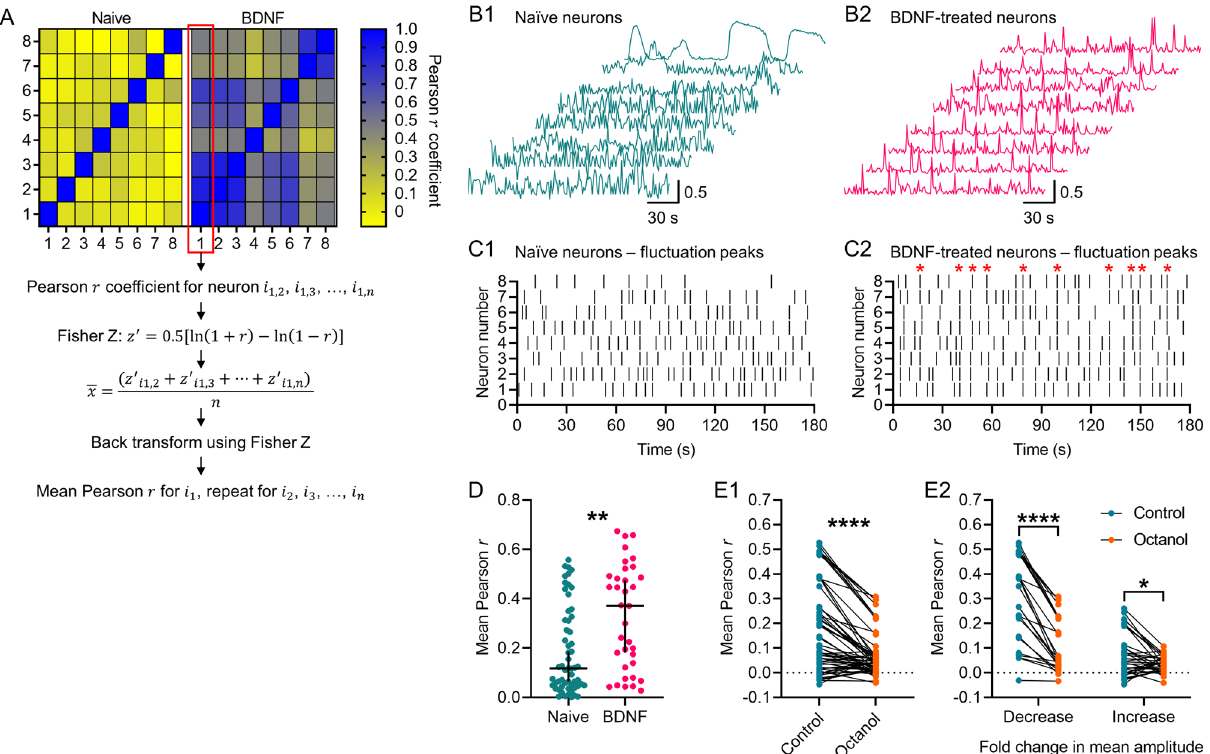
Figure 3. Synchrony of [Ca2 +] i fluctuations in BDNF-treated cultures and the effect of octanol. ( A ) Example adjacency matrix constructed from Pearson r coefficients corresponding to the correlation in activity between neurons in a naïve or BDNF-treated culture, each with 8 sampled neurons. Steps to calculate the mean Pearson r for each neuron within a culture using the Fisher Z transformation are also depicted. ( B1 , B2 ) Example recordings of asynchronous [Ca 2+ ] i fluctuations in naïve neurons and synchronous [Ca 2+ ] i fluctuations in BDNF- treated neurons. Recordings shown were processed by FIBSI for event detection and each one was normalized (0 to 1 scale) before calculation of the adjacency matrix in A. ( C1 , C2 ) Raster plots depicting the fluctuation peak times detected by FIBSI for the recordings in B1-B2. Red stars in C2 denote the presence of synchronous waves of [Ca 2+ ] i activity. ( D ) Neurons sampled from BDNF-treated cultures exhibited significantly greater mean Pearson r coefficients compared to neurons sampled from naïve cultures. Neurons were imaged from 4 naïve cultures and 3 BDNF-treated cultures, each with ≥ 8 neurons imaged. Medians shown with the 95% confidence interval. Medians were compared using a Mann–Whitney test. ( E1 , E2 ) Treatment with octanol significantly decreased the mean Pearson r in neurons sampled from cultures exposed to chronic BDNF, and this treatment effect impacted both subsets of neurons binned based on their initial response to octanol. Neurons were imaged from 4 cultures. The control vs octanol paired comparison in C1 was made using a Wilcoxon rank sum test. Control vs octanol paired comparisons for the groups in C2 were made using a measures two-way repeated measures ANOVA and Sidak’s post-hoc test. * P < 0.05, ** P < 0.01, **** P <